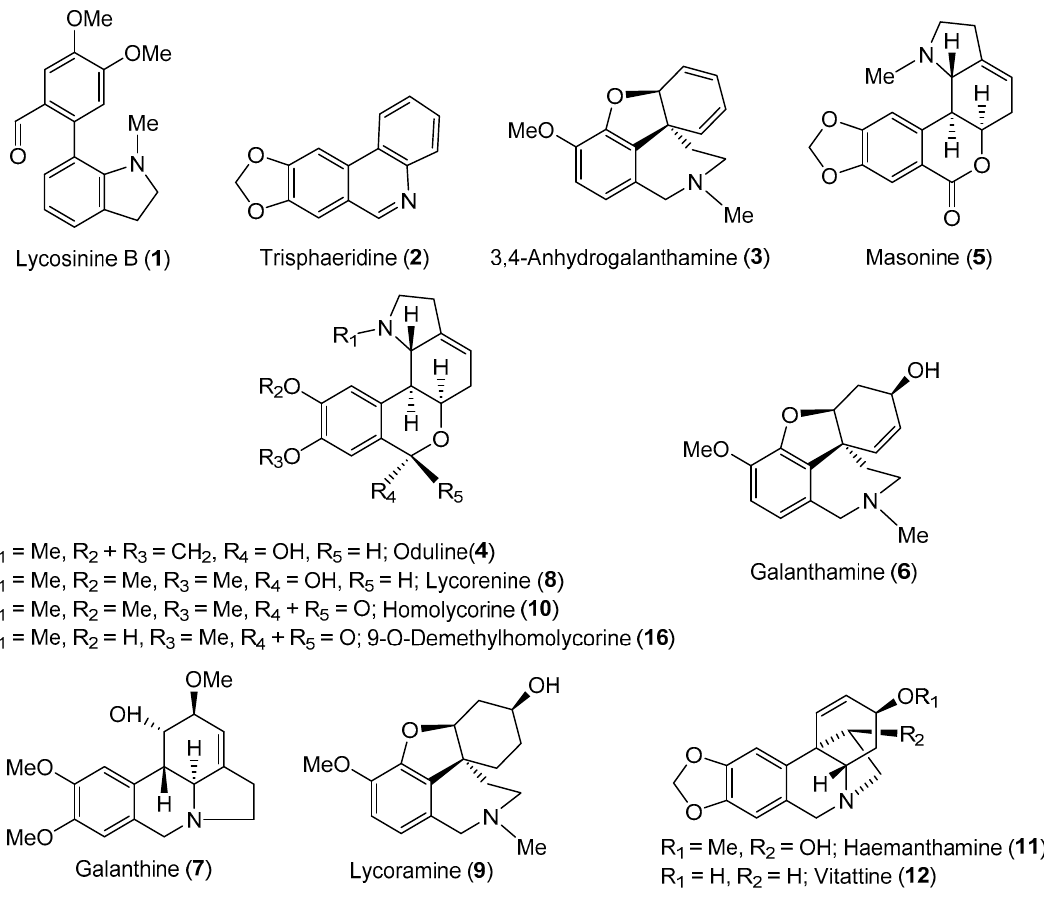
Figure 1. Structures of isolated alkaloids from Narcissus pseudonarcissus cv. Carlton.